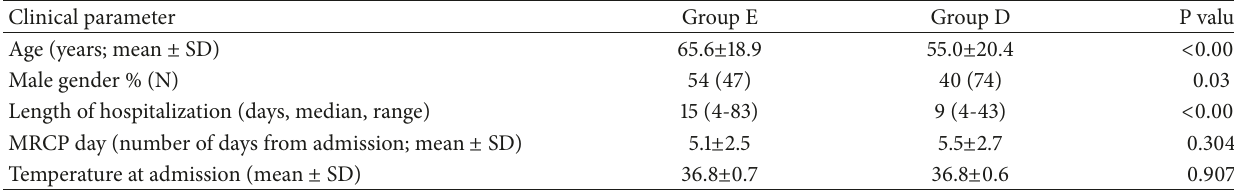
Table 2: Clinical characteristics of the study population: groups D and E.